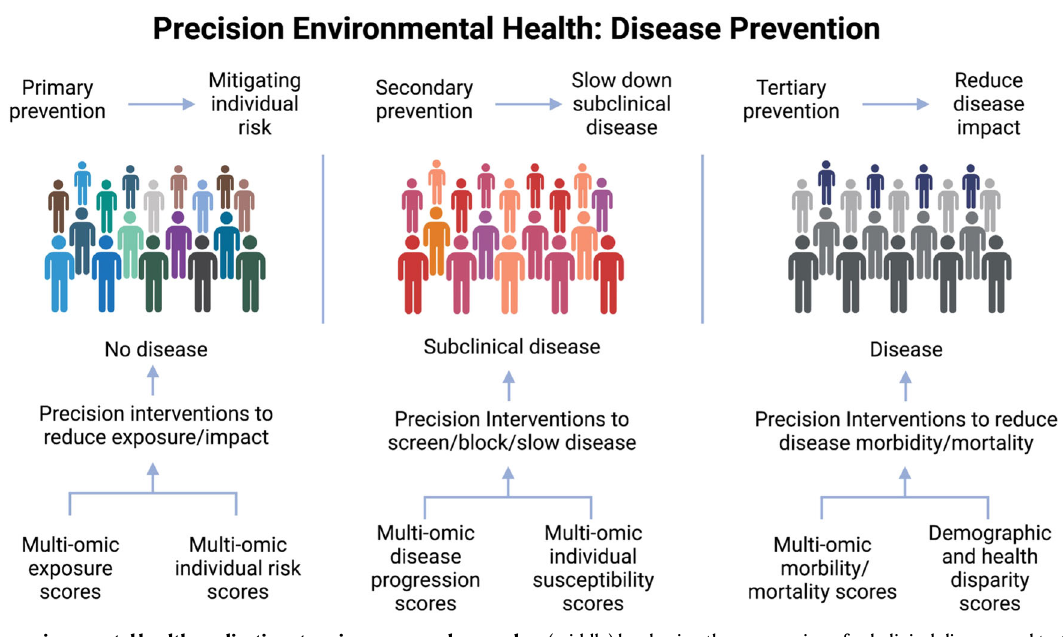
(middle) by slowing the progression of subclinical disease, and tertiary prevention by reducing disease impact (right). Colors are used to indicate diversity within exposed populations. Created with